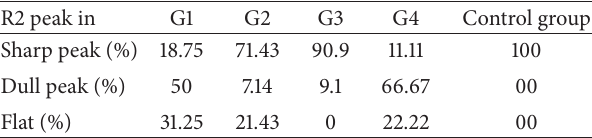
Table 3: Comparison between R2 peak characters in different